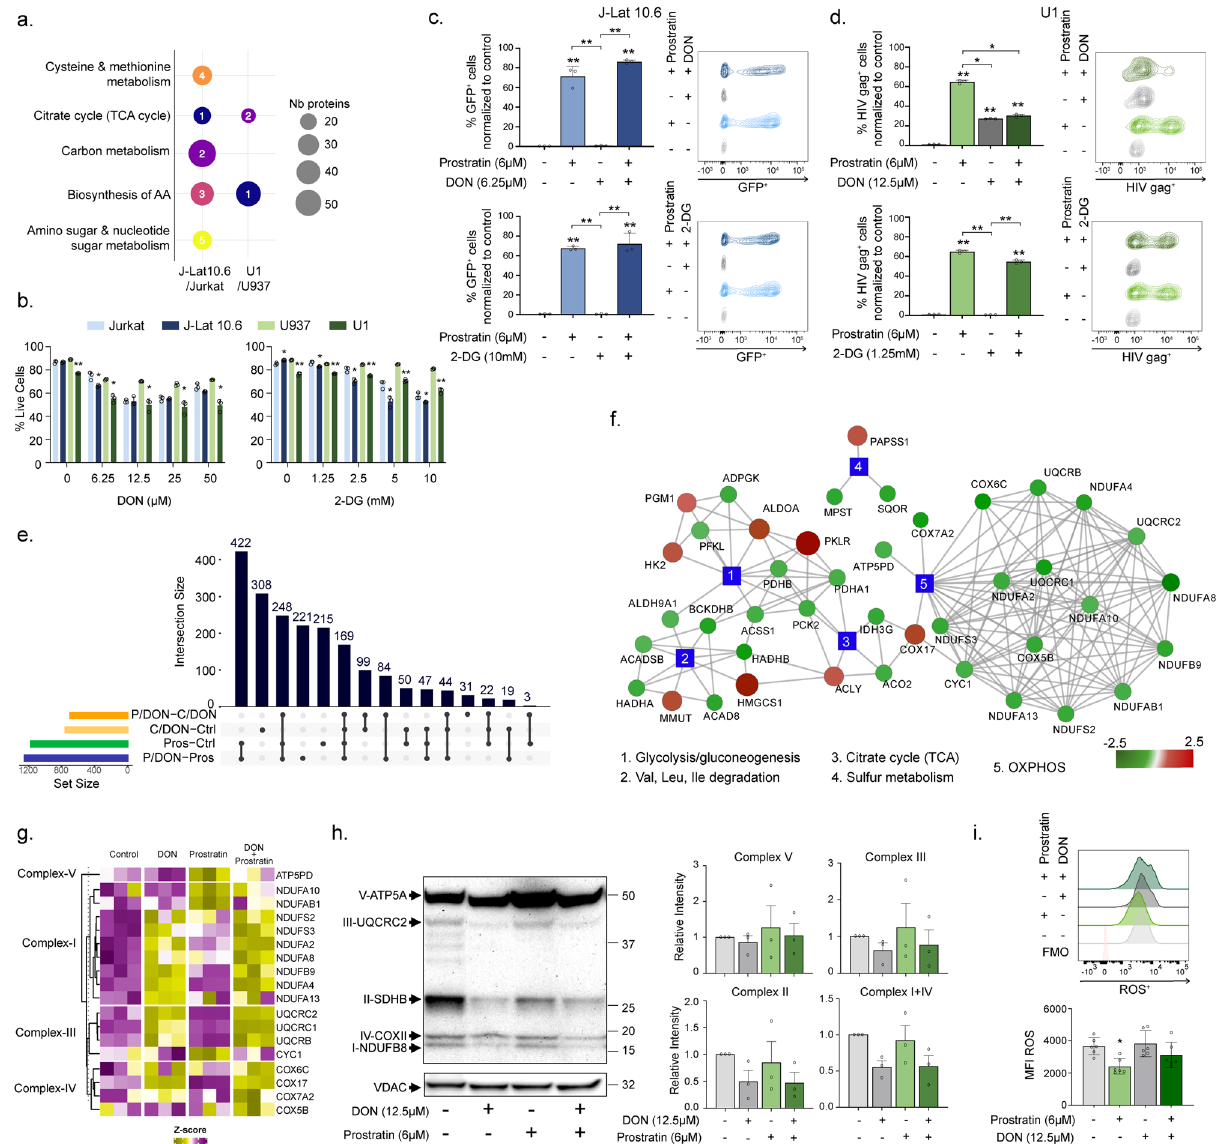
Fig. 4 Effect on cellular metabolism in latency cell models during latency reversal. a Steady-state metabolic alterations in the HIV latency cell models, J- Lat 10.6 (dark blue) and U1 (dark green), compared to Jurkat (light blue) and U937 (light green), respectively. MSEA using the KEGG Metabolism with FDR < 0.05 is shown as bubble plots. The size of the bubble represents the number of proteins and the number, the rank of the pathway based on FDR. b Viability of latency cell models J-Lat 10.6 and U1 compared to respective parental cell lines Jurkat and U937 during 48 h DON or 2-DG treatment measured using fl ow cytometry. c , d HIV latency activation using prostratin (6 μ M) together with DON (6.25 μ M) or 2-DG (10 mM) in J-Lat 10.6 cell line ( c ) and DON (12.5 μ M) or 2-DG (1.25 mM) in U1 cell line ( d ). Data represented as bar graphs (mean ± SD) of three independent experiments. Flow cytometry contour plots are from a representative sample. e The upset plot of proteins with differential abundance between control vs. DON (C/DON-Ctrl, yellow), control vs. prostratin (Pros-Ctrl, green), prostratin vs. DON + prostratin (P/DON-Pros, blue), and DON + prostratin vs. DON (P/DON-C/DON, orange) in U1 cells corrected for U937 cells. Horizontal bars show the number of proteins found in each comparison. Vertical bars display intersects between comparisons as indicated in the matrix below the graph. f Network of the proteins differing signi fi cantly between control U1 and DON treated U1 (LIMMA, FDR < 0.1, n = 758). Blue colored rectangular nodes represent KEGG pathways and colored circles represent proteins. The color gradient was applied depending on log2FC for each metabolite from green (decreased in U1-DON) to red (increased in U1-DON). The size of the bubble is also proportional to log2FC. g Heatmap showing OXPHOS proteins levels in U1 treated with DON and prostratin. Proteins were selected based on comparison U1 vs U1-DON (LIMMA, FDR < 0.1) and their association with the OXPHOS KEGG pathway. Proteins were separated based on their complexes (from I to V). h Western blot analysis and quanti fi cation of OXPHOS proteins during DON treatment in U1 cells with a representative blot of three independent experiments (Fig. S10) are shown here. Quanti fi cation of western blot represented as bar graphs with mean ± SEM. i Measurement of ROS in latency cell model U1 during prostratin and DON treatments. Data represented as mean ± SD of three independent experiments All statistical analysis was performed using unpaired t -test or Mann – Whitney U -test (* p < 0.05, and ** p < 0.001).